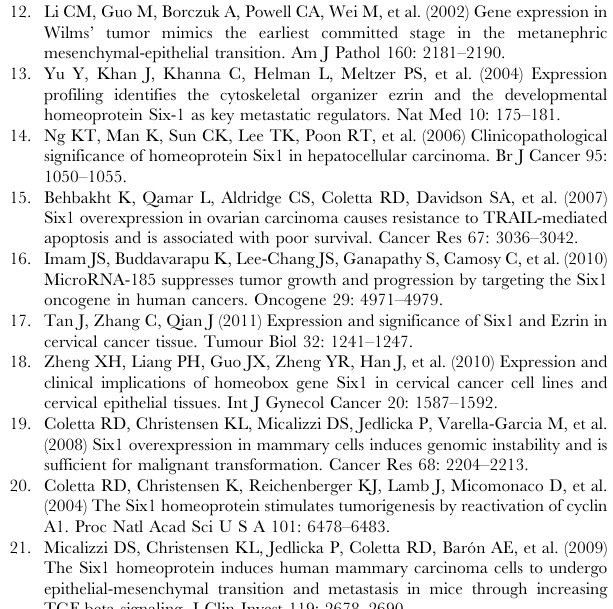
Figure S1 Six1 promotes the growth of PANC-1 and MIA PaCa-2 cells. A, Western blot analysis of the expression of Six1 and cyclin D1 in MIA PaCa-2 cells. B and C, MTT growth assays and colony formation assay of the cells stably transfected either with Six1 or control plasmids. D and E, Cell numbers (D) and percentage of BrdU positive cells (E) of Six1 siRNA and scramble